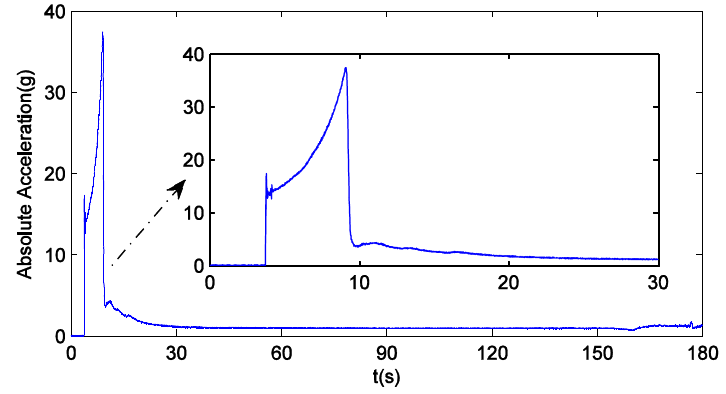
Figure 12. The absolute acceleration of the missile.